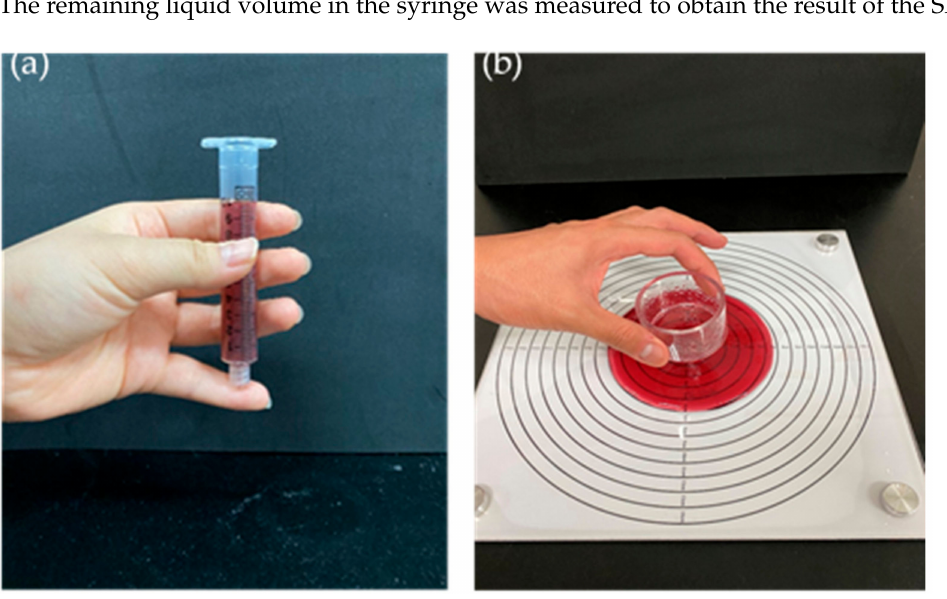
Figure 1. ( a ) syringe flow test (SFT) and ( b ) line-spread test (LST) for thickened